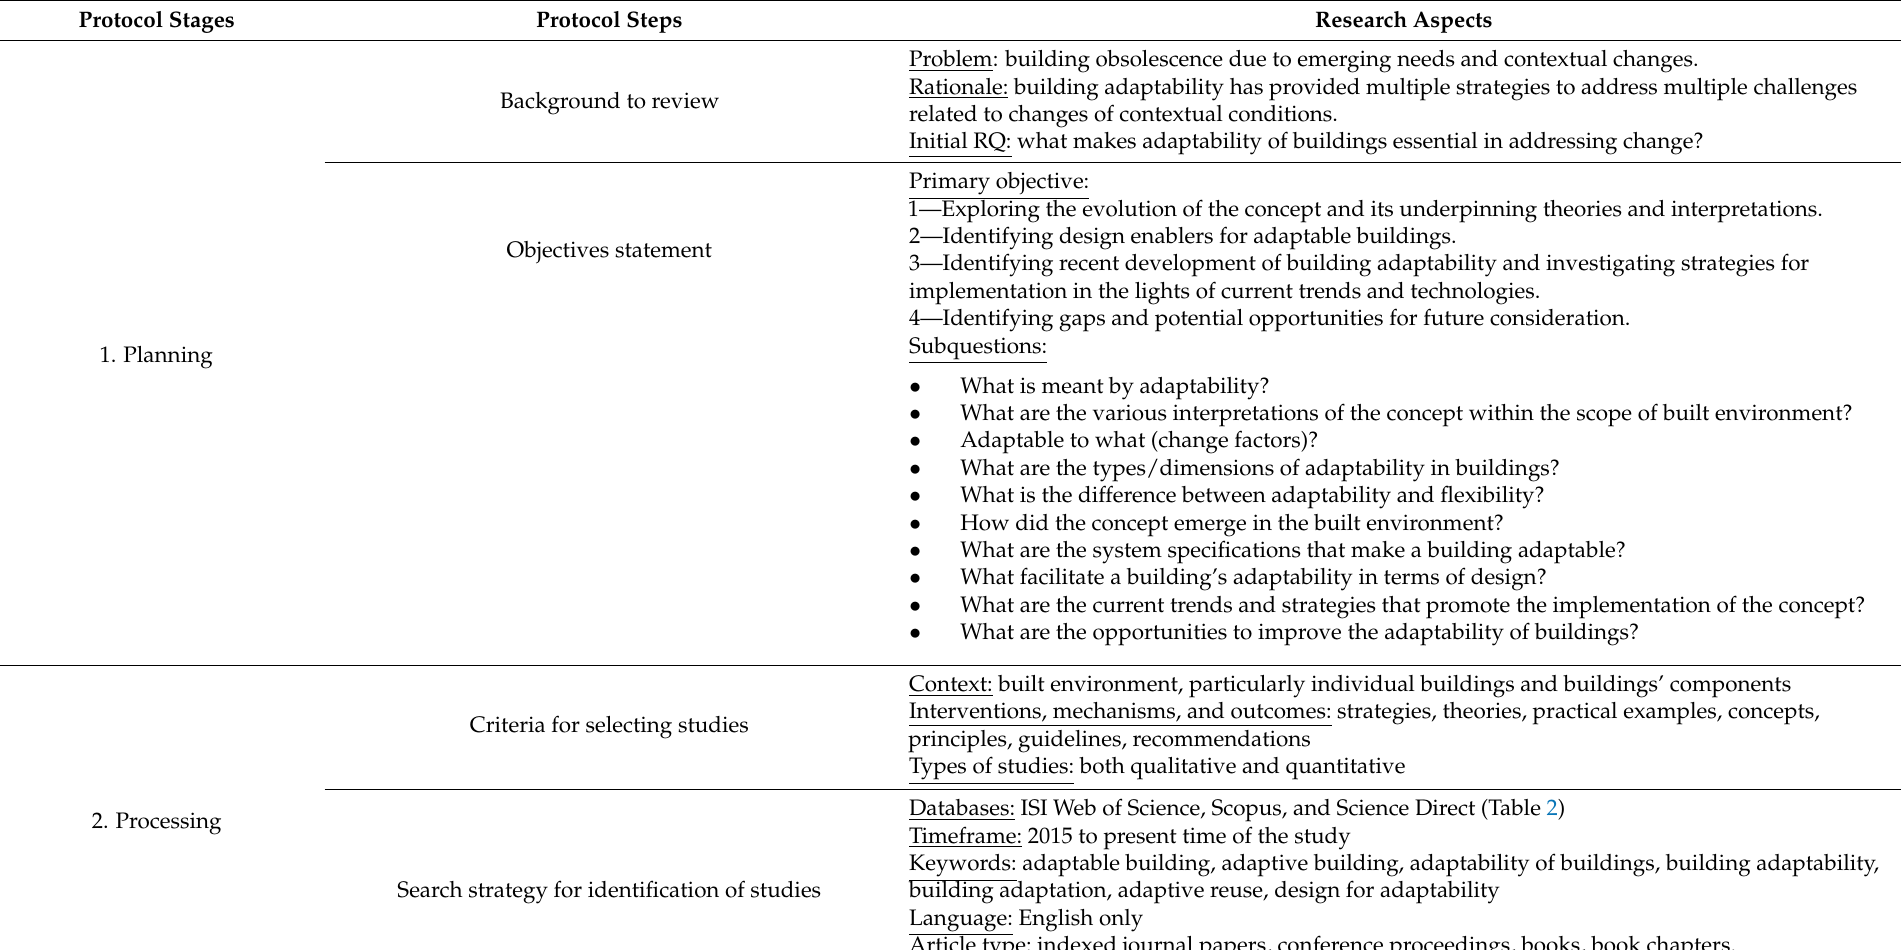
Table 1. Systematic literature review protocol for this